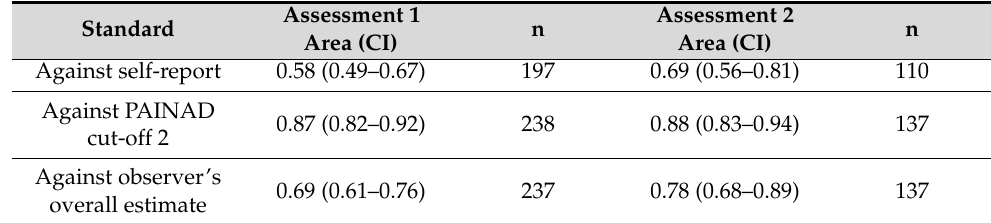
Table 6. Area under ROC curve.